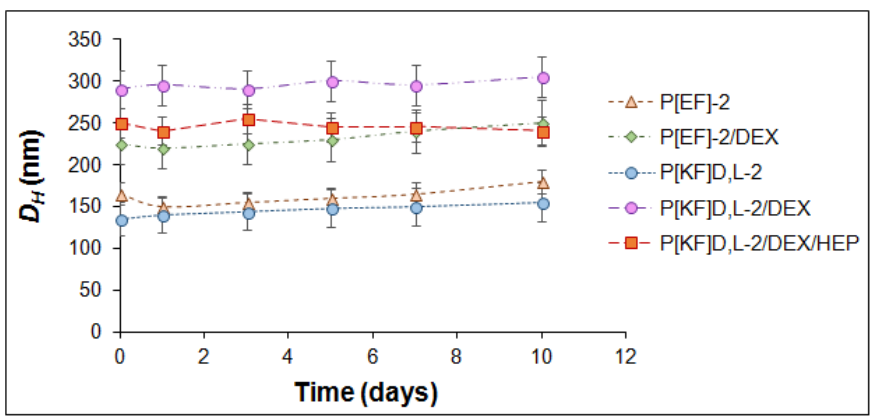
Figure 10. DLS monitoring of hydrodynamic diameters over time for neat nanoparticles and their conjugates with DEX stored at 0.01 M phosphate buffer solution and room temperature (20 °C).